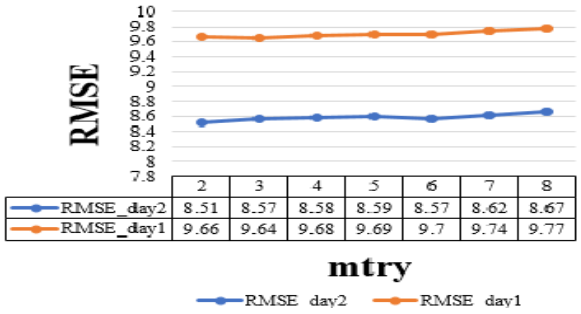
Figure 2. Choosing the most optimal mtry considering the RMSE value for both days.